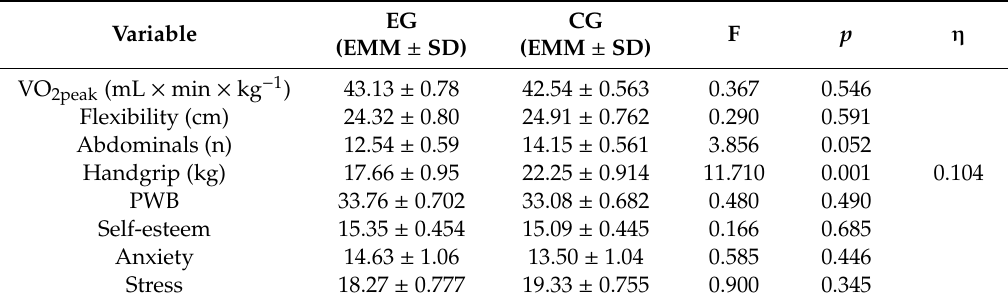
Table 3. Results of the univariate analysis of covariance.